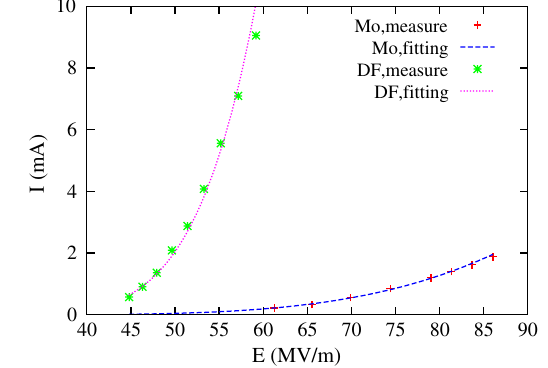
FIG. 13. Beam current for different samples. The diamond films (DF) are deposited on molybdenum